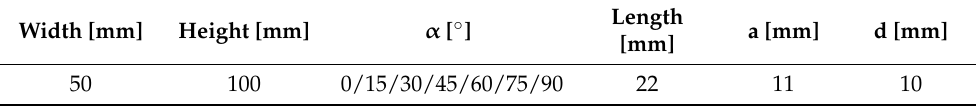
Figure 2. The model diagram and numerical model diagram. Table 1. The dimension parameters of defect combination models with different crack angles.